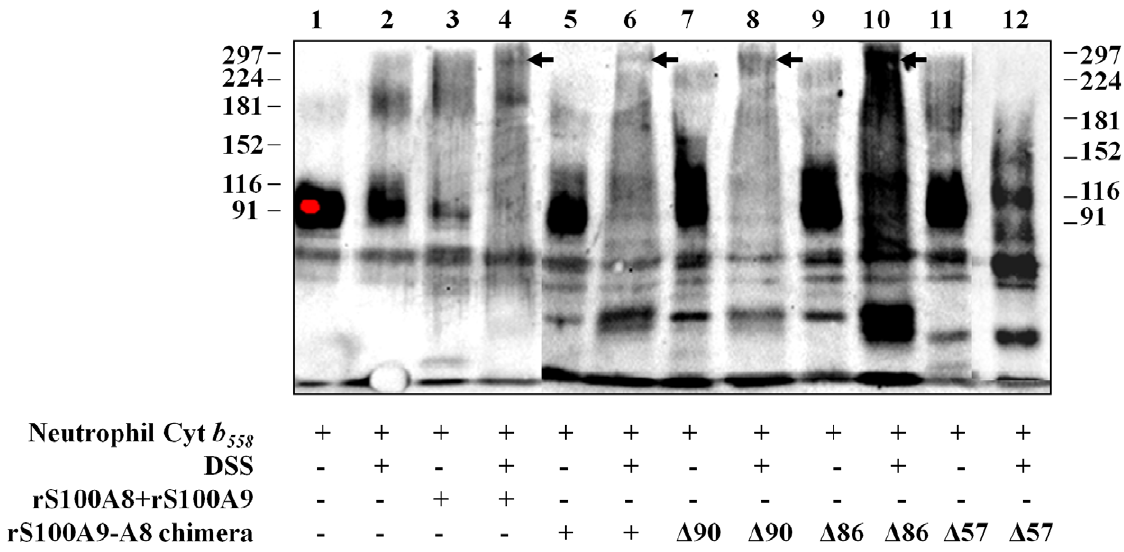
Figure 7. Disuccinimidyl suberate (DSS) complex formation between cytochrome b 558 and recombinant S100A8 and S100A9 proteins. Recombinant rS100A8 and rS100A9 proteins (1.5 nmol) or rS100A9-A8 full-length and truncated chimera proteins (1.5 nmol ) were pre- incubated with 500 nM calcium before adding 10 pmol of purified cytochrome b 558 in the presence of 10 m M FAD, 40 m M GTP c S, 5 mM MgCl 2 and 1 mM of arachidonic acid and then 2 mM DSS (or not). After 1 h incubation at room temperature, the protein complexes were separated by 7% SDS- PAGE and electro transferred on nitrocellulose for Western blotting. Cytochrome b 558 was labeled with rabbit polyclonal antibodies raised against the C terminal sequence of gp91 phox [31]. The immune complexes were stained by ECL. The representative results represented correspond to one out of five experiments performed. Cyt b 558 , Cytochrome b 558 .